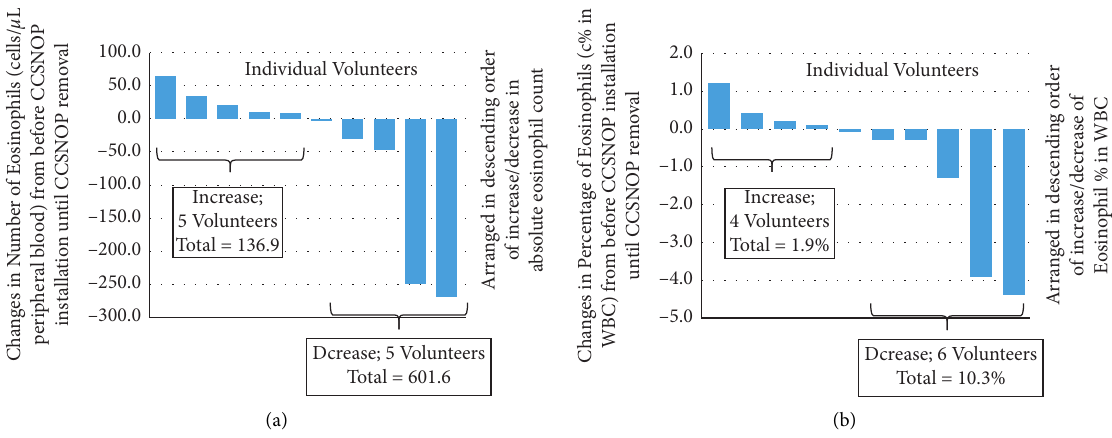
Figure 4: Comparison of the average change in the number (% multiplied by total WBC number/ μ L) (a) or percentage of white blood cells (b) encompassing the period before installation of CCSNOP until removal of the CCSNOP panel for the 10 volunteers. The 5 left-most columns in (a) and 4 left-most columns in (b) increased and the total increase in number or percentage was added and indicated. 5 right- most columns in (a) and 6 right-most columns in (b) decreased. The total absolute number or percentage of increases or decreases is